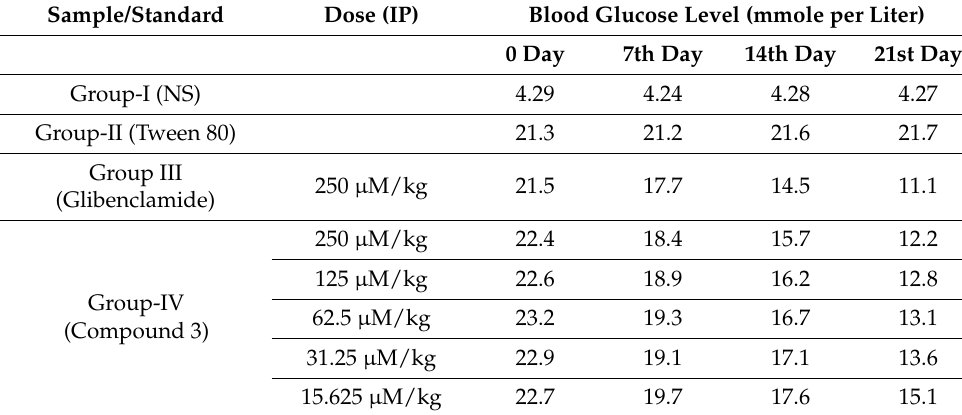
Table 2. In-vivo anti-diabetic assay of the synthesized